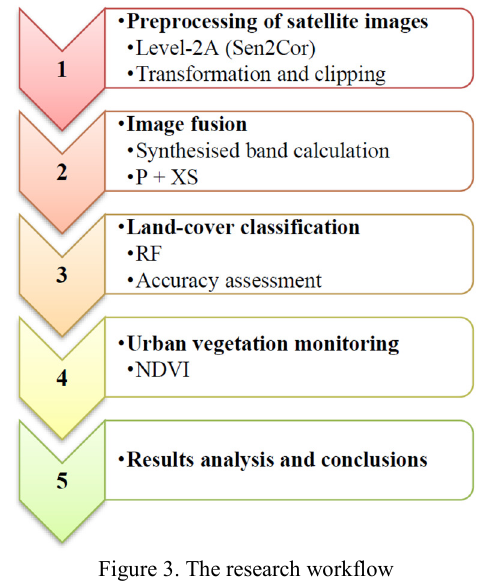
Figure 3. The research